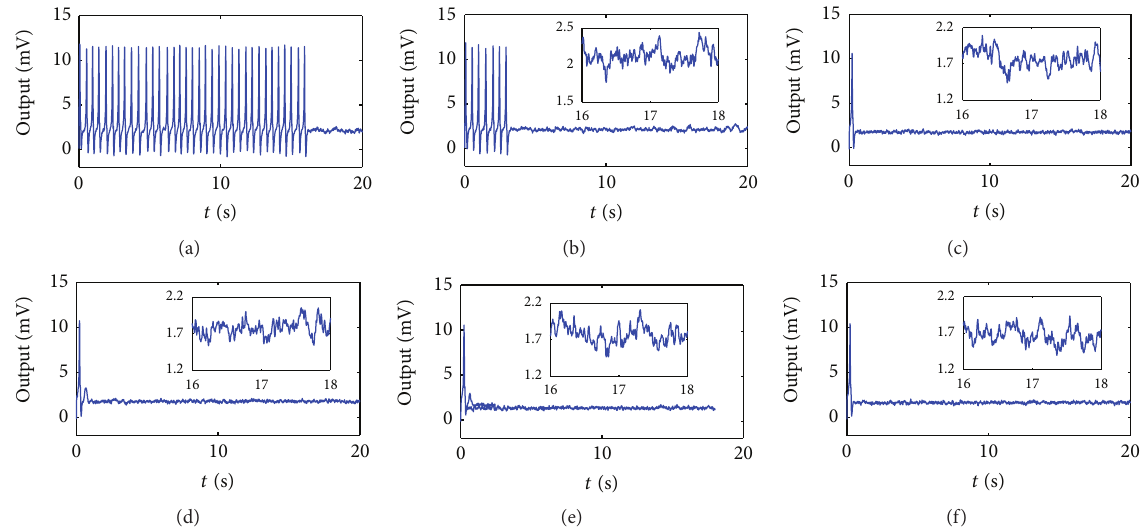
Figure 9: The output waveforms of population 2 for different values of 𝑘 𝑝1 . (a) 𝑘 𝑝1 = 0.65 . (b) 𝑘 𝑝1 = 0.68 . (c) 𝑘 𝑝1 = 0.7 . (d) 𝑘 𝑝1 = 0.74 . (e) = 0.95 . (f) 𝑘 = 1.3 𝑘 𝑝1 𝑝1